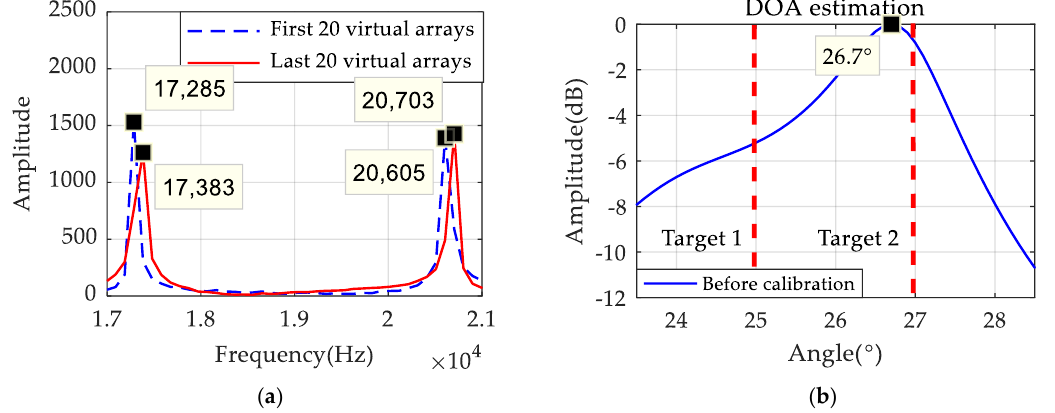
Figure 9. ( a ) FFT results of virtual arrays when targets in motion; ( b ) The DOA results before calibration. To correct the frequency migration, a method based on time stretching transform is presented.